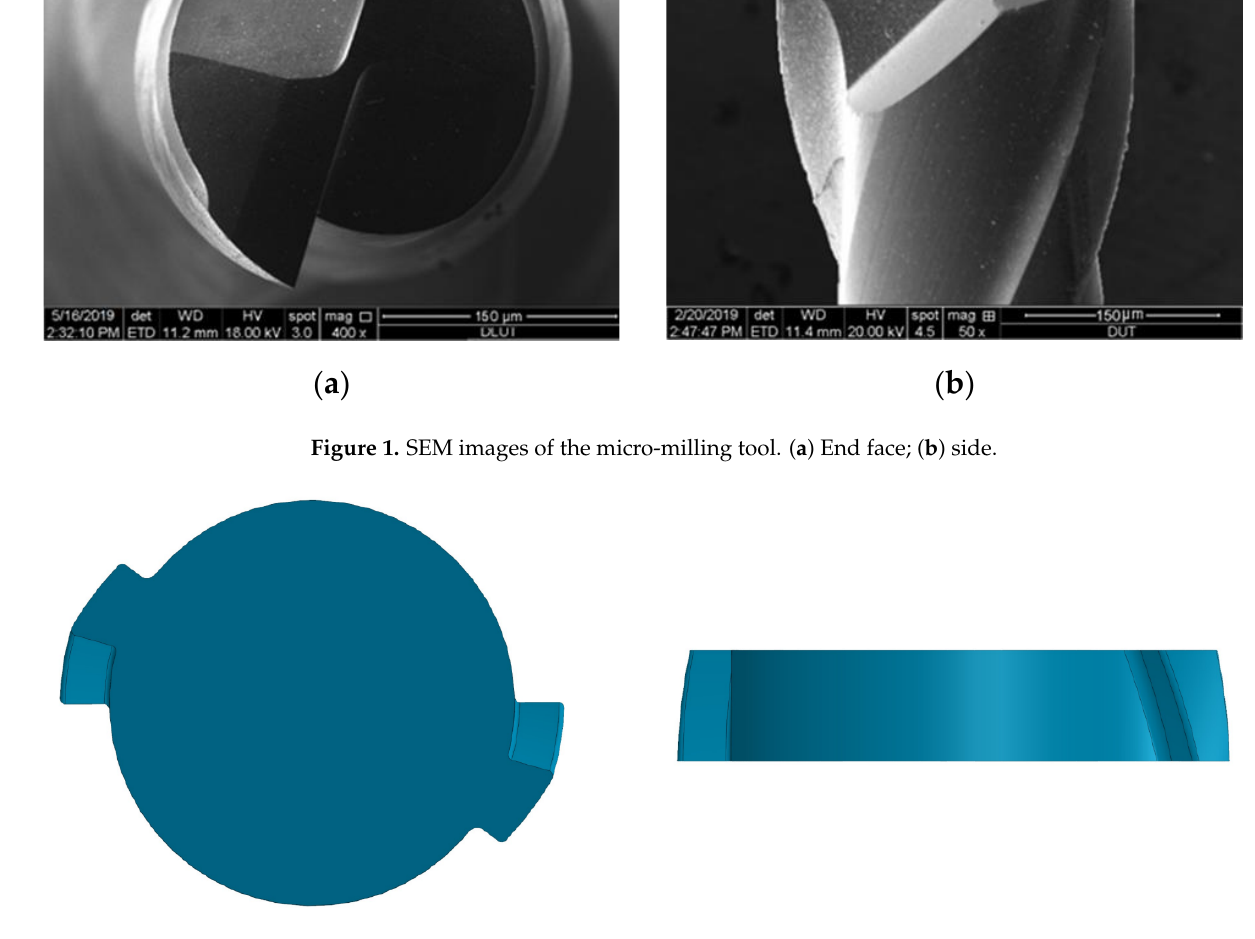
Figure 2. Three-dimensional model of the micro-milling tool. ( a ) End face; ( b ) side.